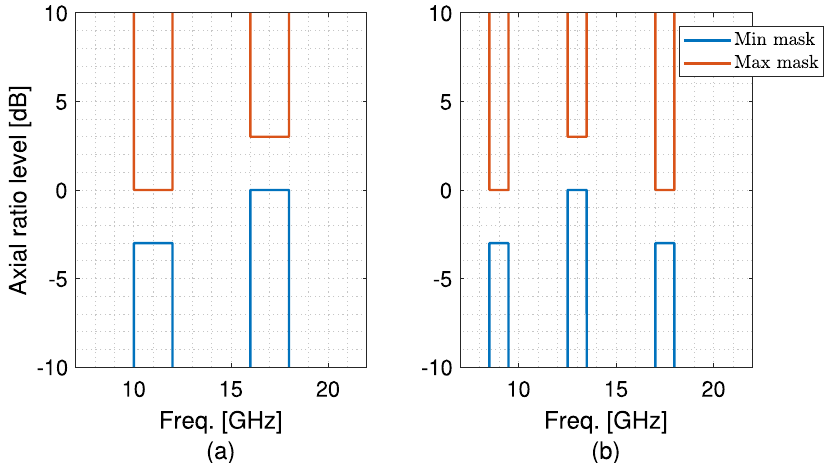
Figure 4. AR dispersive minimum and maximum masks for the ( a ) dual-band and ( b ) triple-band